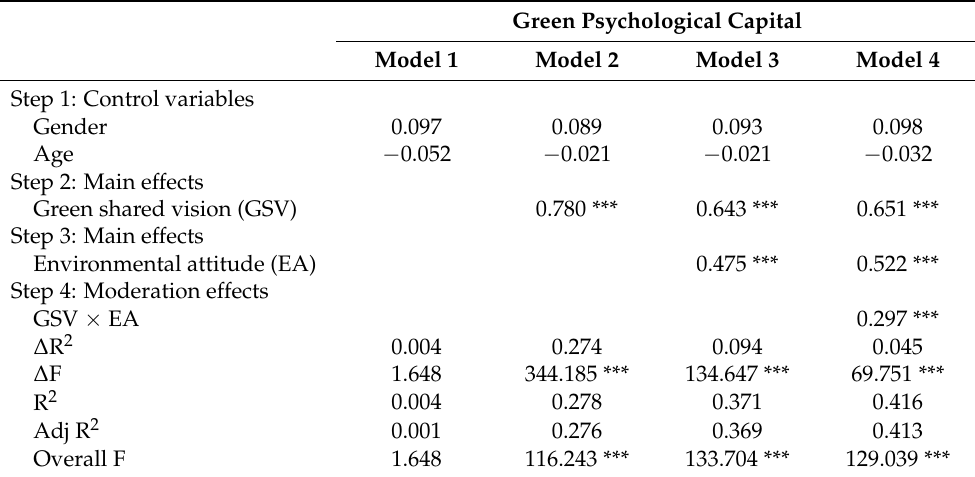
Figure 2. Moderating role of green organizational ambidexterity.